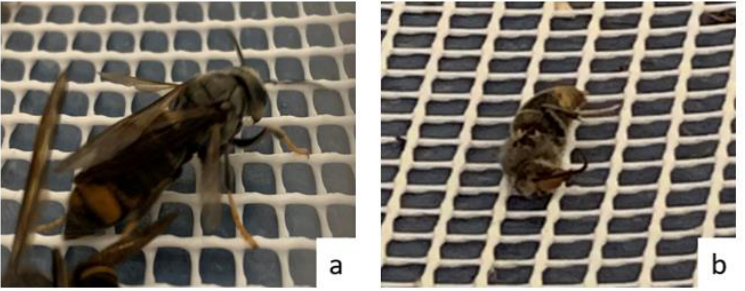
Figure 8. Newly born in captivity Vespa velutina with the characteristic whitish colouring of the first days after hatching ( a ). Attacked male Vespa velutina hornet with some of its legs and wings lost ( b ). However, the number of new hornets decreased throughout the captive